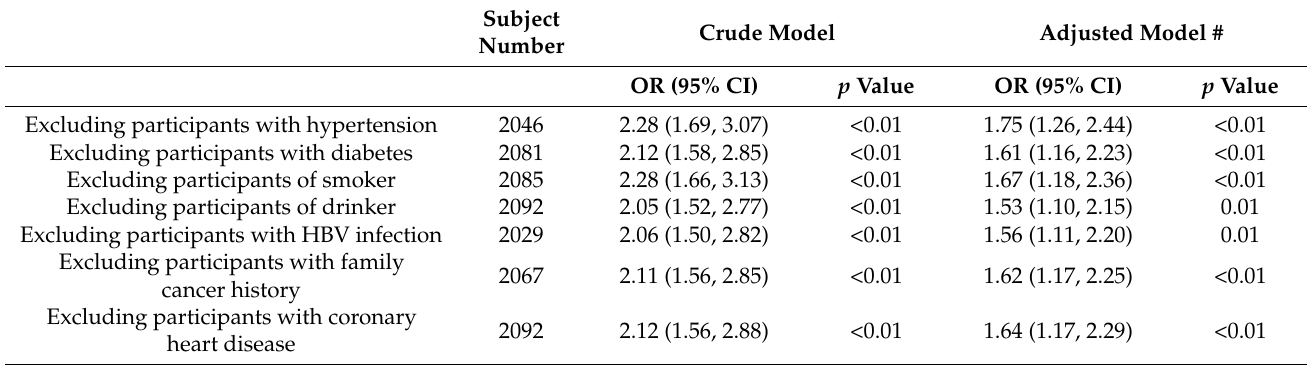
Table 6. Sensitivity analyses on the association of HEV exposure and all cancer risk among males younger than 45